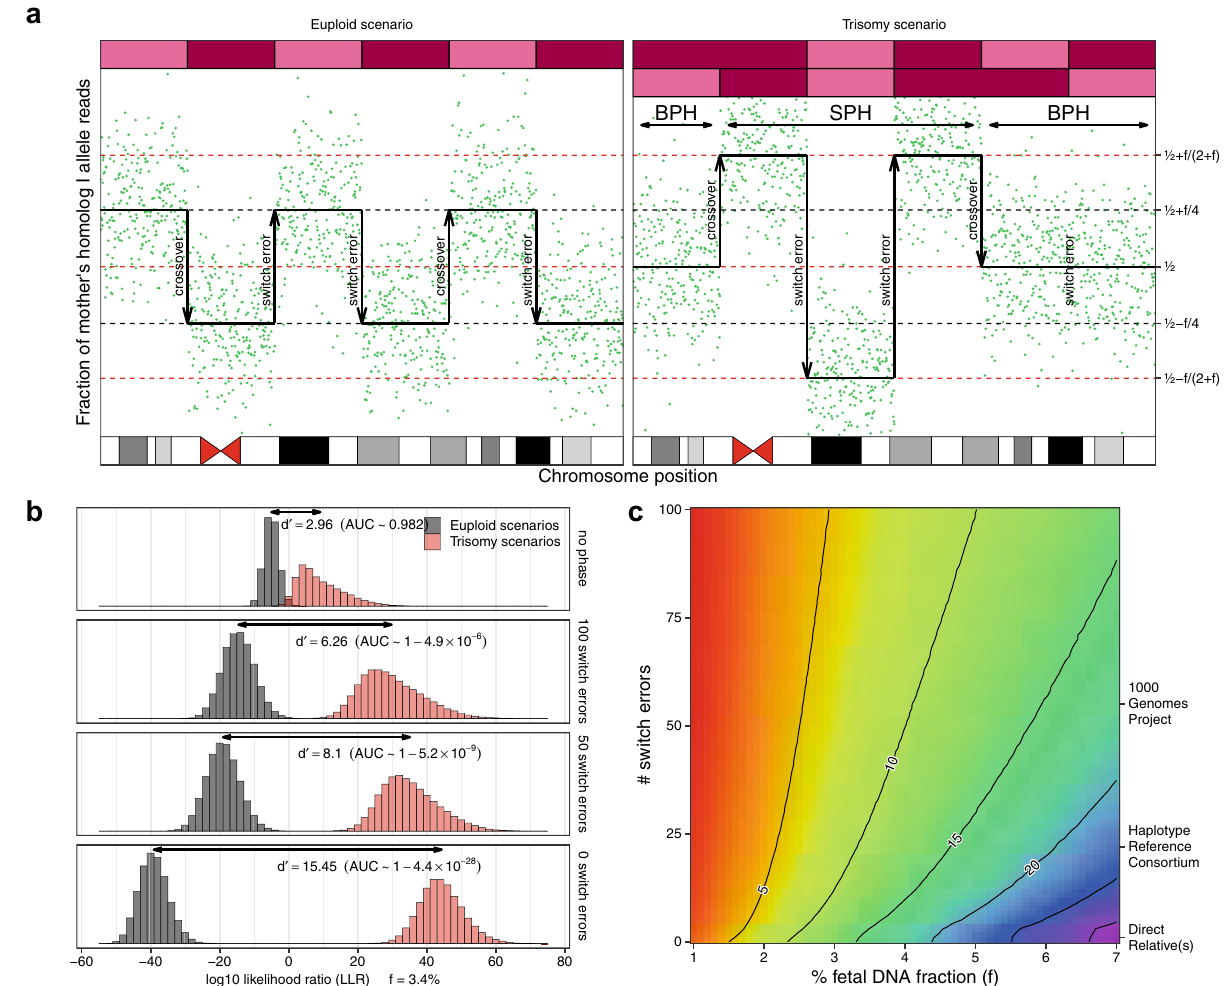
Figure 2. Simulation of log 10 likelihood ratio (LLR) discrimination statistics. ( a ) Simulated allelic fractions from the maternal plasma of a pregnant woman with crossovers and switch errors. The top bars represent the simulated maternal homologs inherited by the fetus, with magenta and red representing, respectively, mother’s homolog I and mother’s homolog II. Notice that, in the trisomy scenario, switch errors don’t change the expected proportion of alleles when occurring in BPH segments. ( b ) Simulated log 10 likelihood ratio (LLR) discrimination statistics from simulations with a fetal DNA fraction specified as f = 3.4%, and an average sampling of 2000 sequence fragments at 1500 loci heterozygous for the mother, for both trisomy and euploid scenarios. Sensitivity index d’ between the LLR discrimination statistics for the two models is displayed together with the AUC estimated as if the two LLR discrimination statistics were normally distributed. As the number of switch errors decreases, the ability of the LLR discrimination statistic to distinguish the euploid and trisomy scenarios increases. ( c ) Sensitivity index d’ between LLR discrimination statistics for allelic read counts simulated by trisomy scenarios and those simulated by euploid scenarios as a function of fetal DNA fraction and the number of switch errors. For reference, a representative chromosomal phase accuracy using different chromosomal phasing approaches is reported on the right. Contour lines follow parameters sets with the same sensitivity index d’, indicating scenarios with approximately equivalent power to distinguish euploid and trisomy